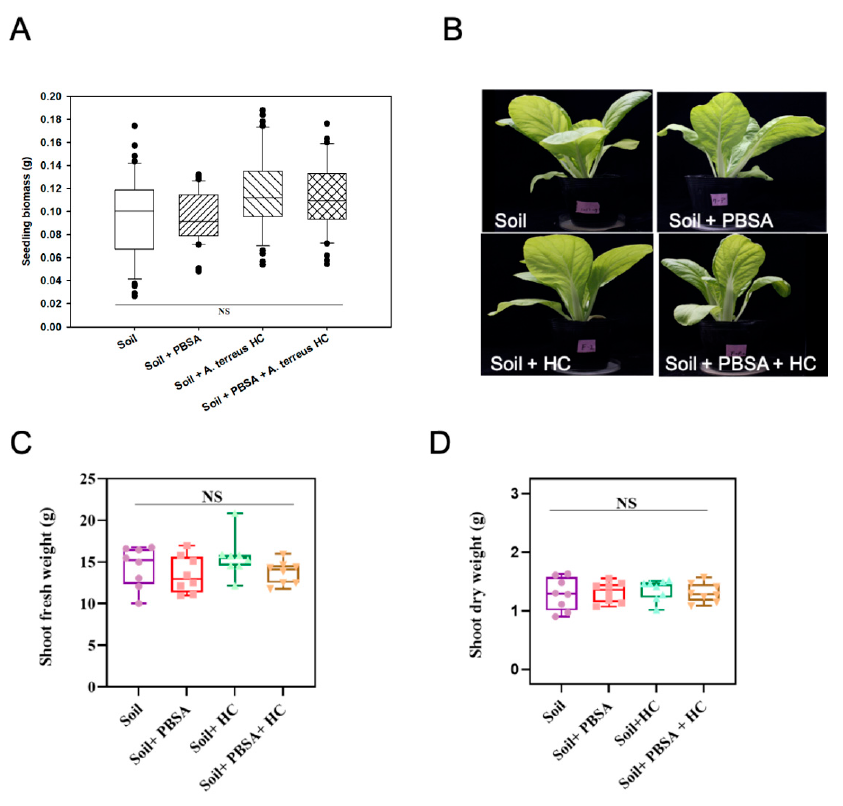
Figure 8. Phytotoxicity assessment of PBSA plastic film residues or A. terreus HC on plant growth. Seeds of Chinese cabbage were cultivated in soil containing 30-day degraded PBSA film residues to determine the seedling vigor for assessing phytotoxicity. ( A ) The biomass of Chinese cabbage seedlings was assessed after 8 days of germination. ( B ) The phenotype of Chinese cabbage at 21 days of cultivation. ( C , D ) Fresh and dry weights of shoots after 21 days of cultivation in soil containing PBSA residues. Ns: no significant difference among the treatments. The results are presented as the mean ± standard deviation ( p < 0.05; Tukey’s post hoc ANOVA